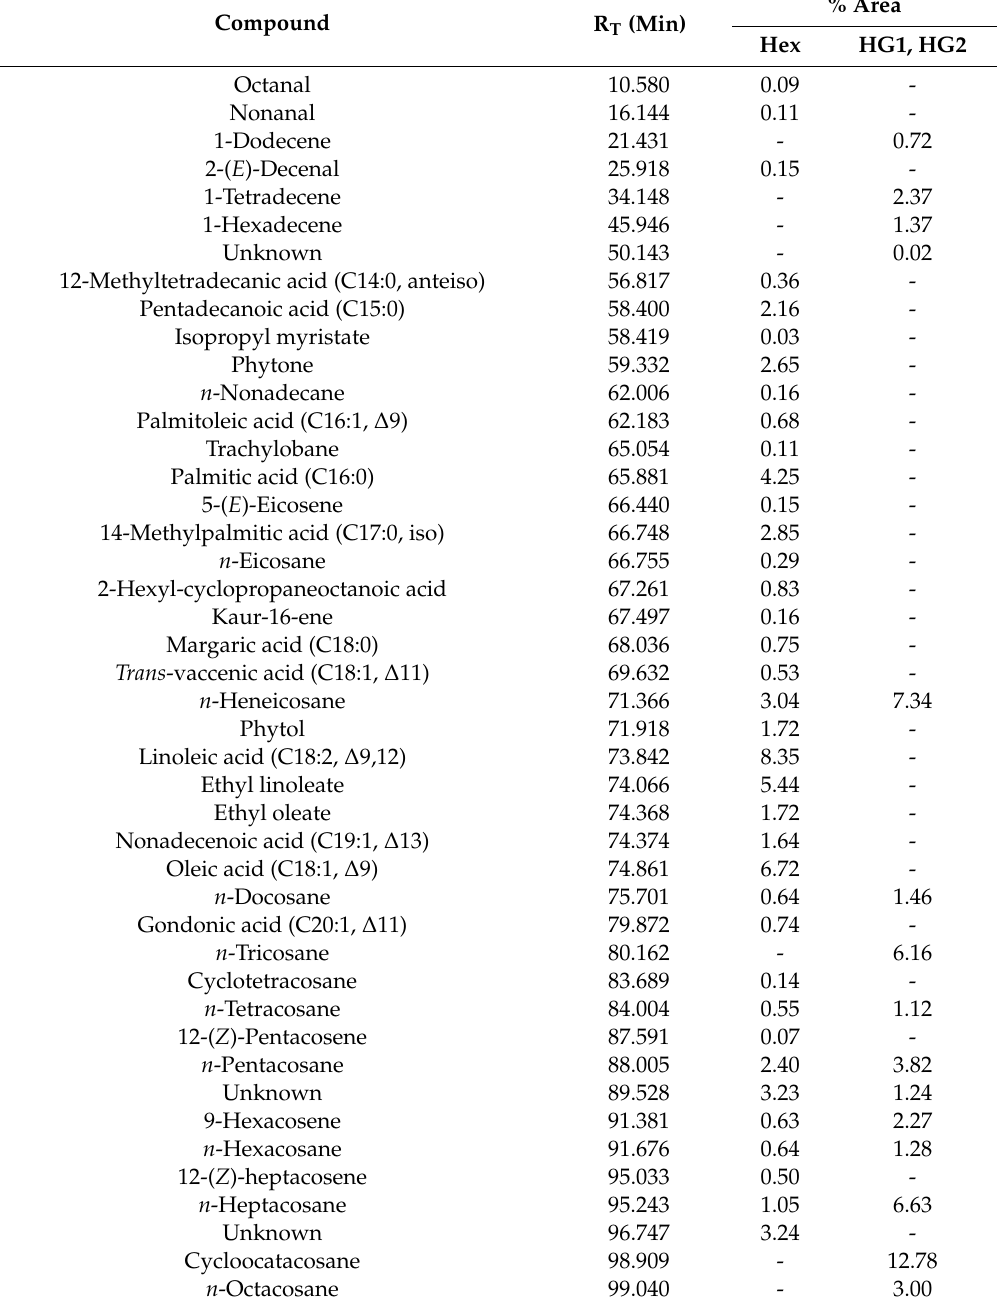
Table 1. GC-MS analysis of Hex extract, compounds 1 - 5 , HG1 and HG2 from H. glomerata